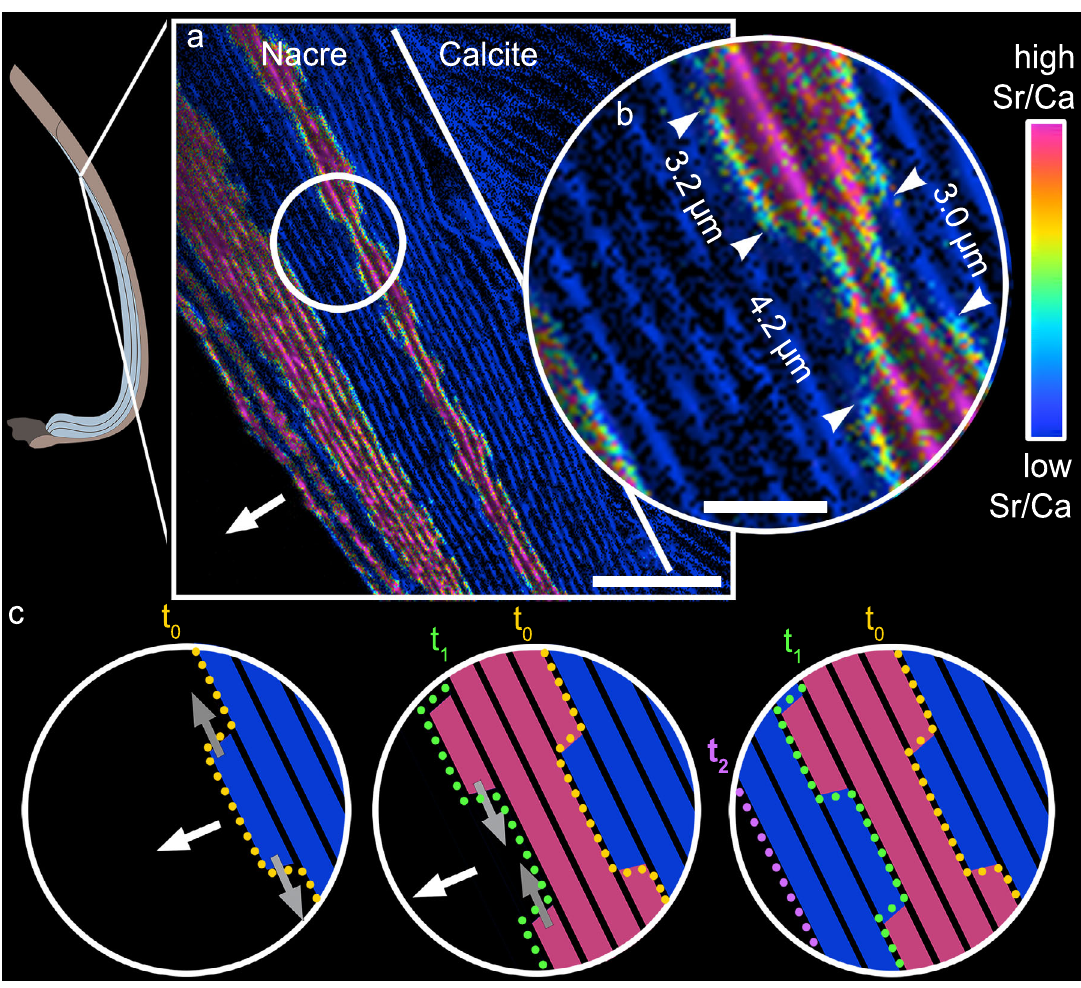
Fig. 2 | NanoSIMS imaging of nacre growth processes visualized via Sr pulse- chase labelling. a 88 Sr/ 40 Ca ratio map sized 50×50 μ m showing four Sr labels (magenta)andunlabellednacre(blue)paralleltothenacregrowthfront(specimen: M1S1L). The combined unlabelled and Sr-labelled nacre layers have average Sr concentrations of 2,100 μ g/g and 12,500 μ g/g, respectively (Supplementary Table2).Thelabellednacrelayersexhibitastepped growth patternof intercalated nacretabletsformedinseawaterwithnormalSrconcentration(blue)andduringSr- labelling (magenta). b Magni fi ed region of interest (circled in a) shows sharp (i.e., within 100nm) near-vertical transitions, marked by white arrowheads, between labelled and unlabelled portions of nacre lamellae. The sizes of neighbouring